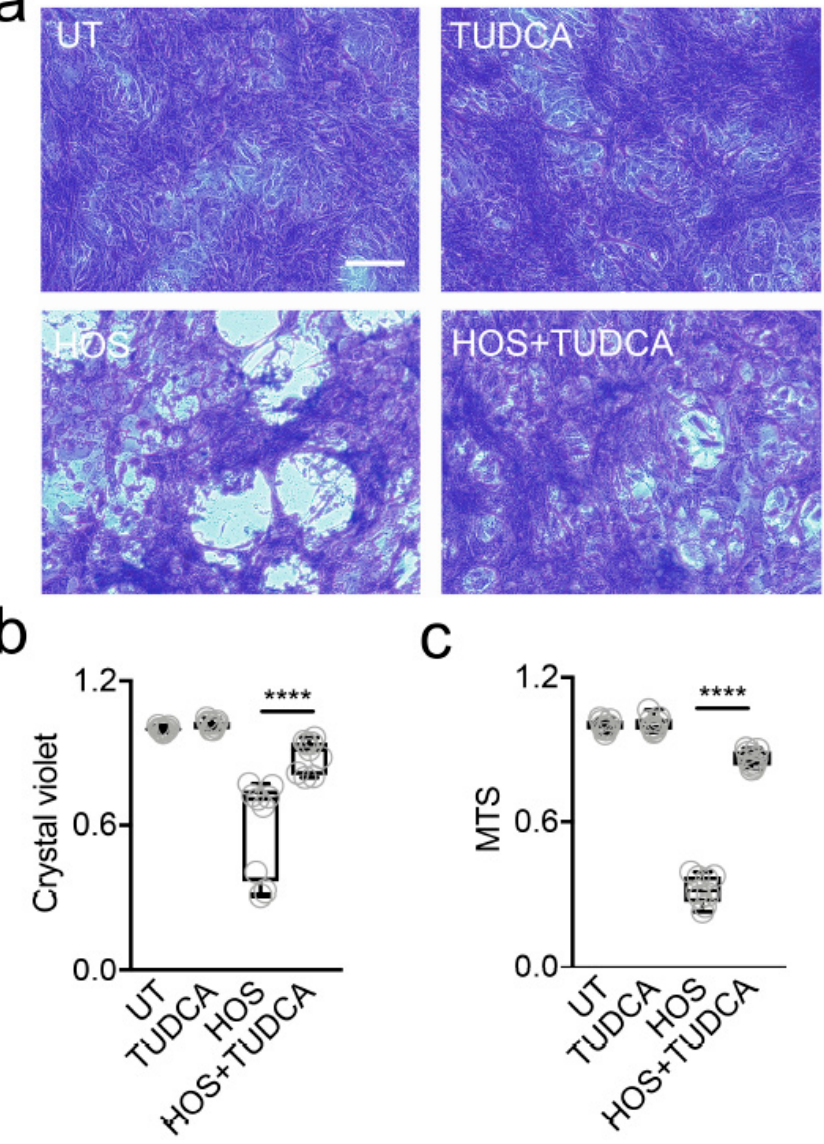
Figure 3. TUDCA reduces hyperosmotically induced cell death. ( a ) Crystal violet staining of stratified human corneal epithelial cells: untreated (UT), treated with 1 mM TUDCA alone (TUDCA), or exposed to HOS (94 mM NaCl, 24 h) with or without addition of TUDCA. Scale bar: 10 µm. ( b ) Quantitative assessment of the cellular area covered by crystal violet in ( a ) normalized-to-UT- control ( n = 3 independent experiments in triplicate). ( c ) Quantitative assessment of cell